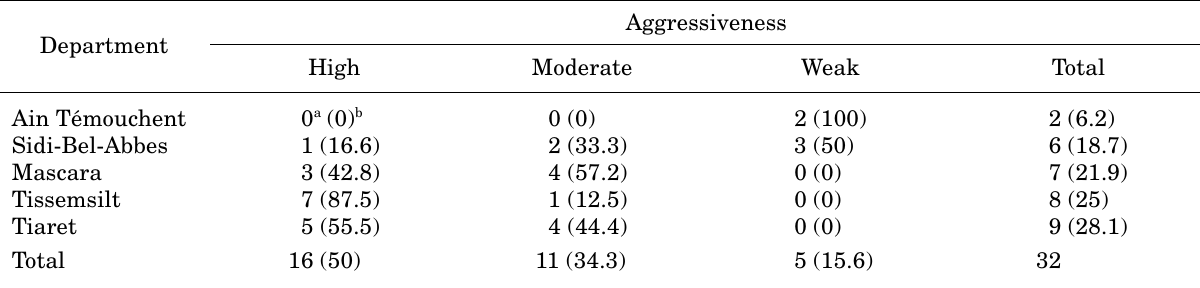
Table 3. Distribution of isolate aggressiveness in relation to geographic origin.